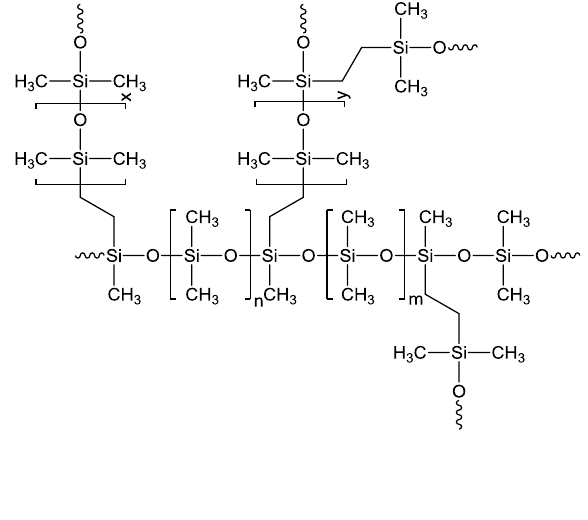
Figure 1. Schematic representation of crosslinked poly(dimethlsiloxane)